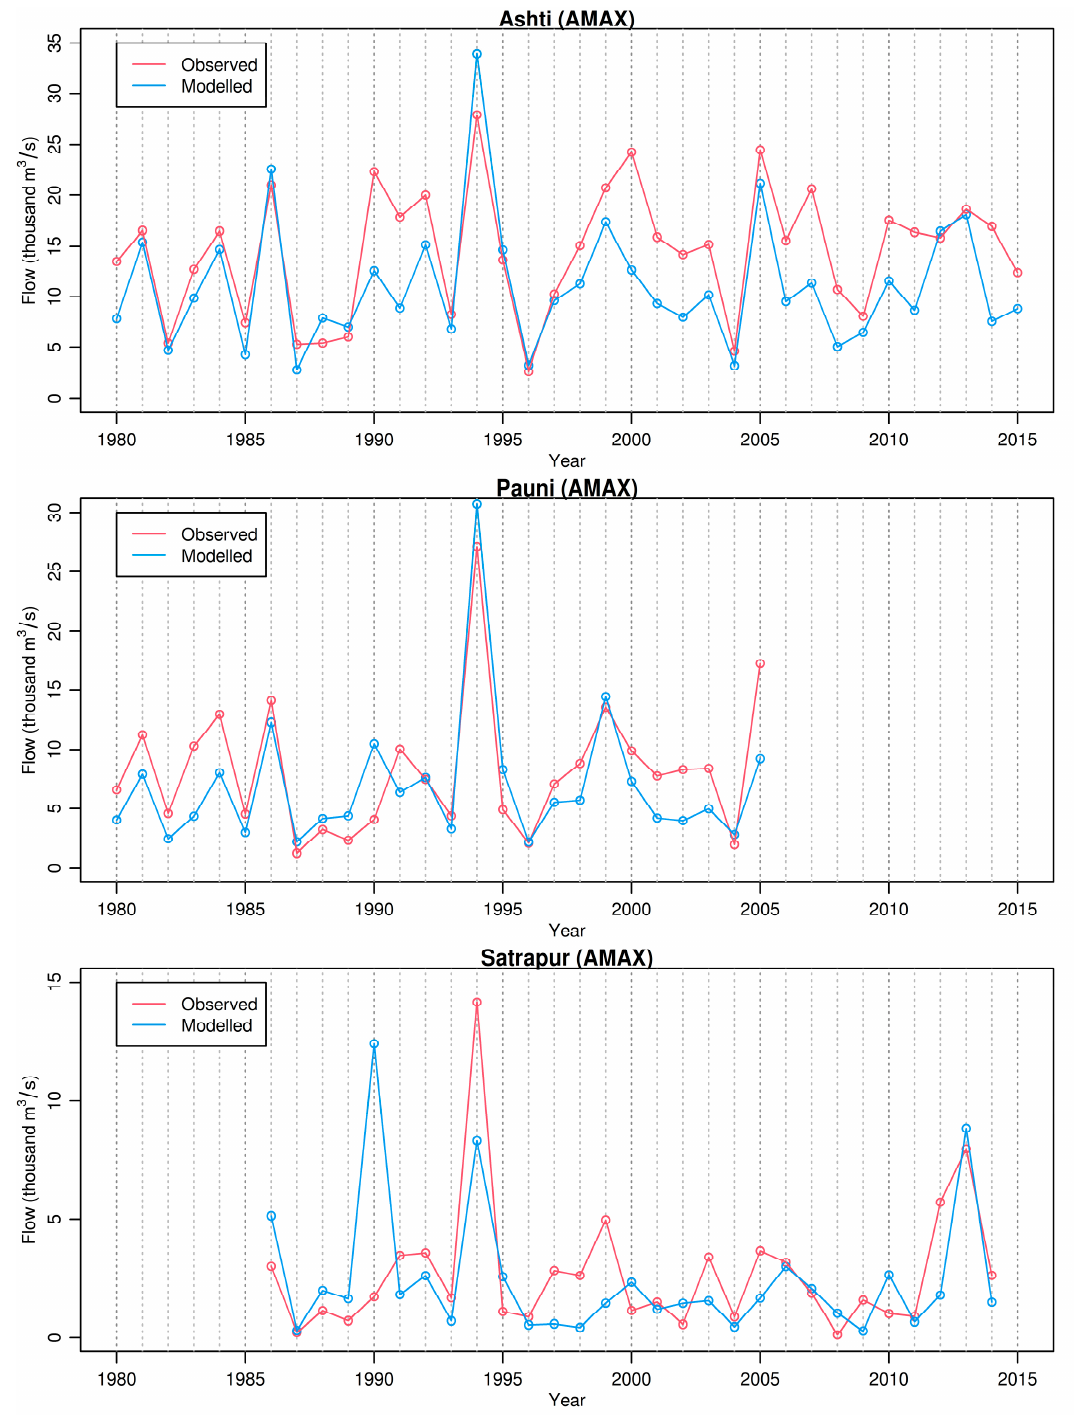
Figure 11. Observed and modeled AMAX series for Ashti, Pauni and Satrapur for semi-lumped modeling.